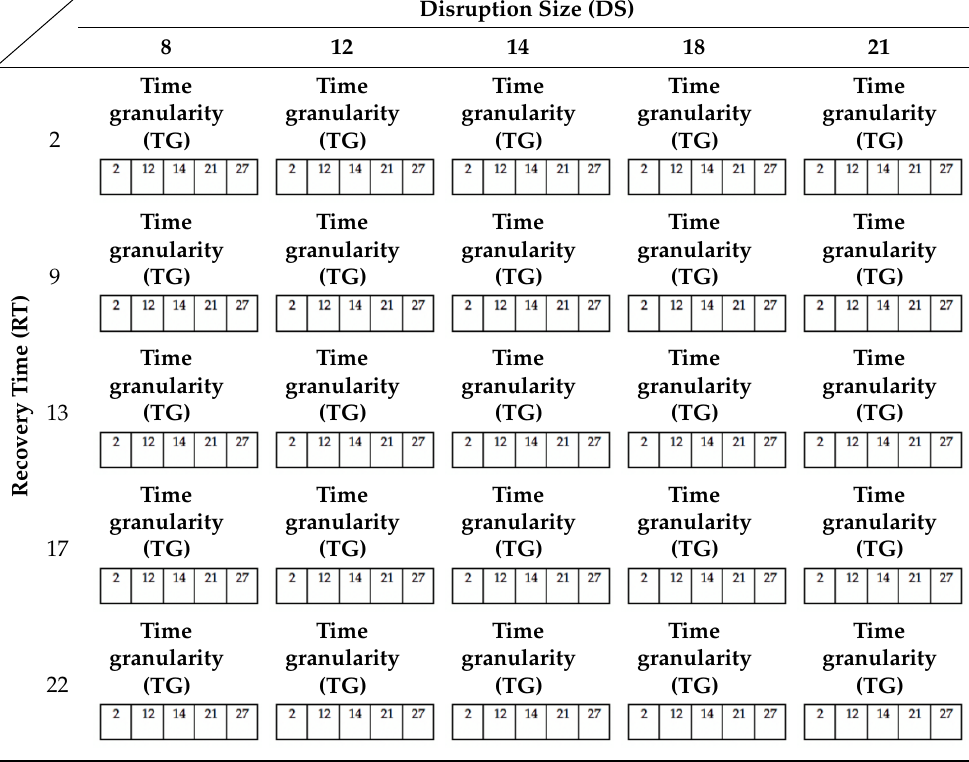
Table 1. 5 × 5 × 5 hypercube full-factorial layout achieved via LHS. Experimental factors included time granularity (TG), recovery time (RT), and disruption size (DS).